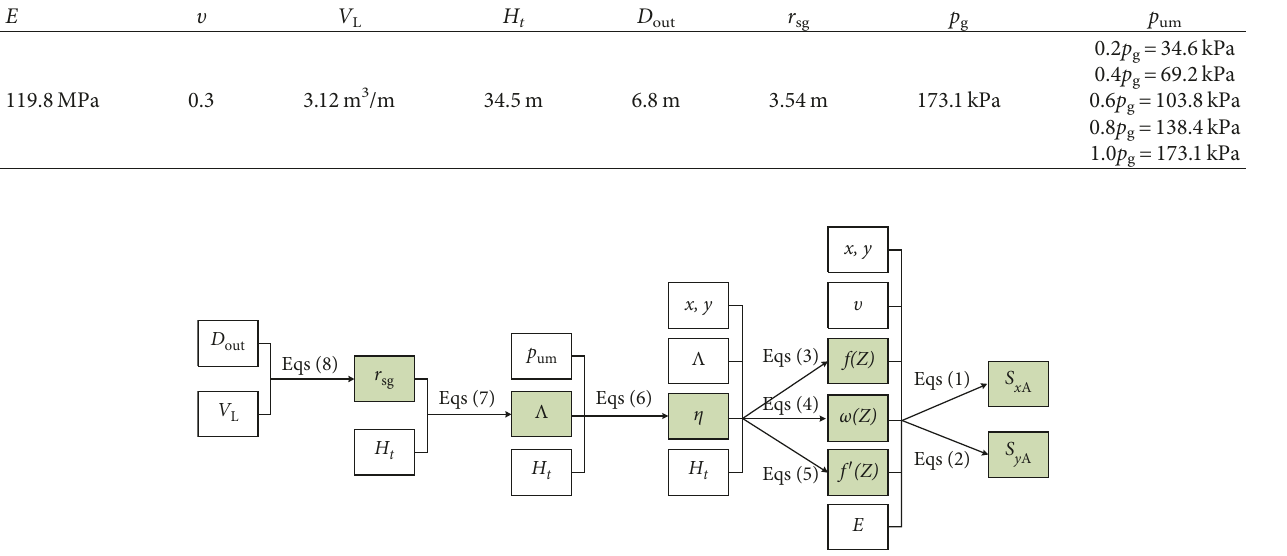
Figure 6: Flow chart for calculating the vertical displacement of ground surface.